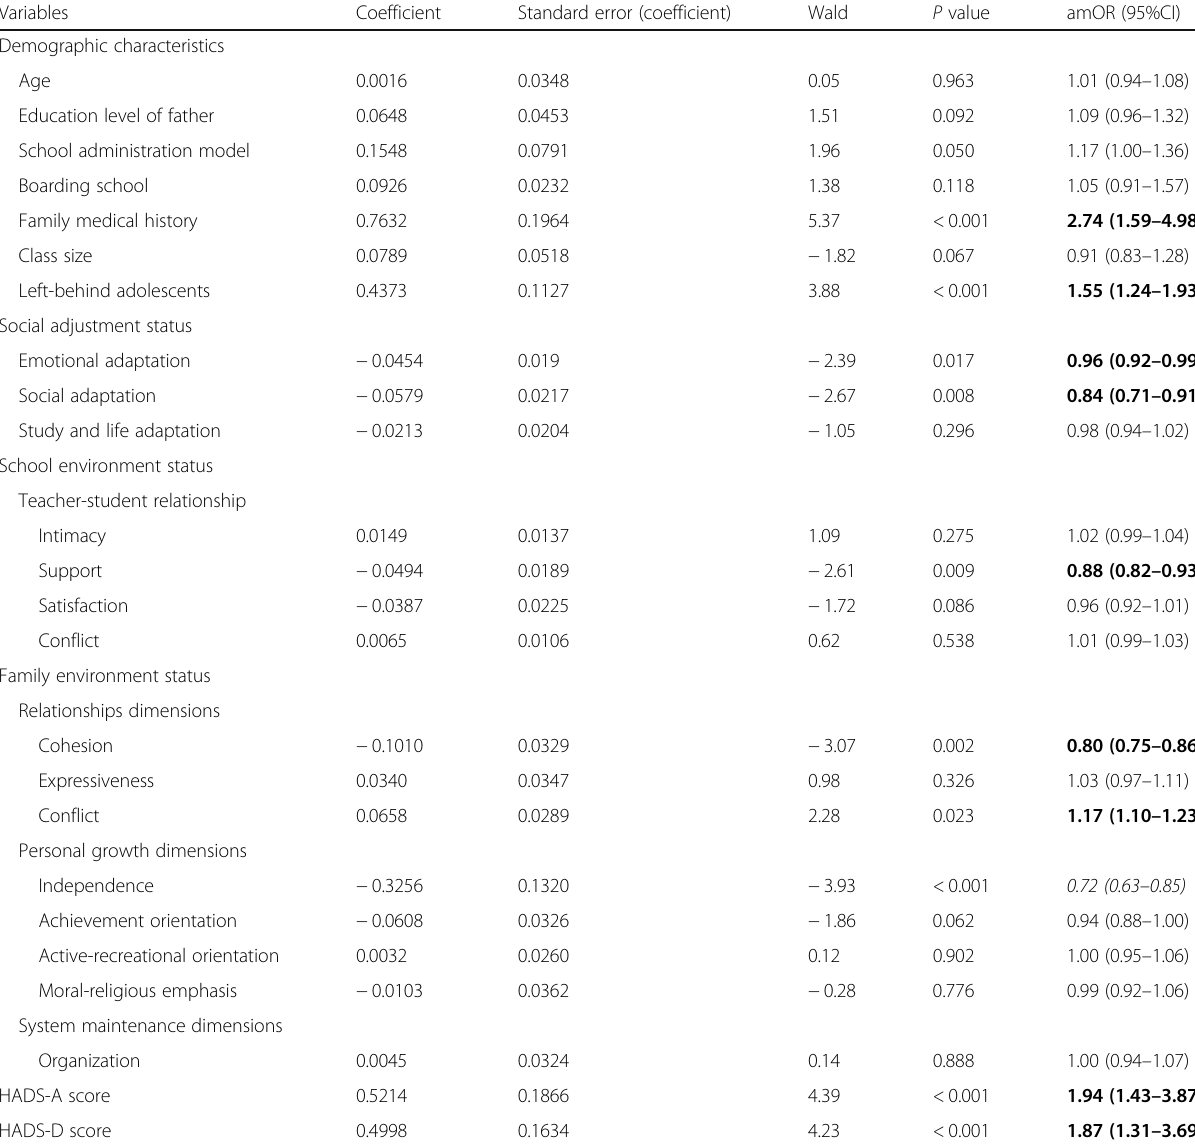
Table 5 Analyses of conditional multiple logistic regression of female HTs on HT-associated environment factors